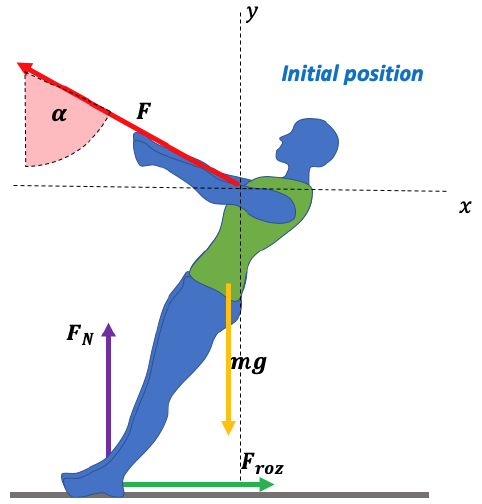
Figure 1. Initial position and reference angles for the calculation.